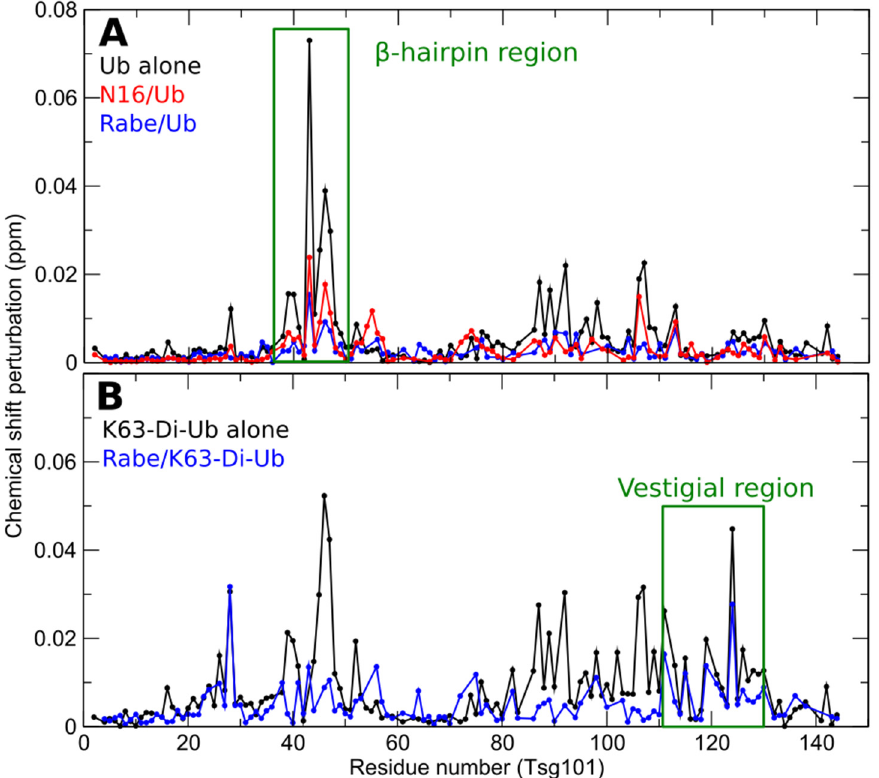
Figure 6. Prazoles block UEV binding of mono- but not di- Ub. Panel ( A ) Chemical shift perturbations of Tsg101 upon addition of ubiquitin, either alone (1:1 ratio–black), or when covalently precomplexed with tenatoprazole (N16, red) [23] or rabeprazole (blue). Panel ( B ) Chemical shift perturbations of Tsg101 upon addition of Lys63-linked di-Ub alone (black) or after first complexing with rabeprazole (blue).